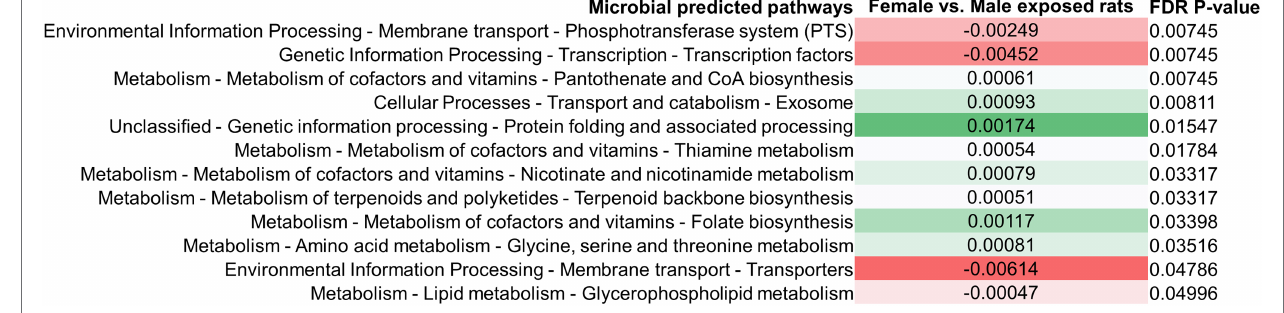
FIGURE 7 | Differences in predicted small bowel microbial functional metabolic pathways in exposed male and female rats on PAbxD13. Pathways shown in red are predicted to be enriched in exposed males, and pathways shown in green are predicted to be enriched in exposed females. Only significant differences are